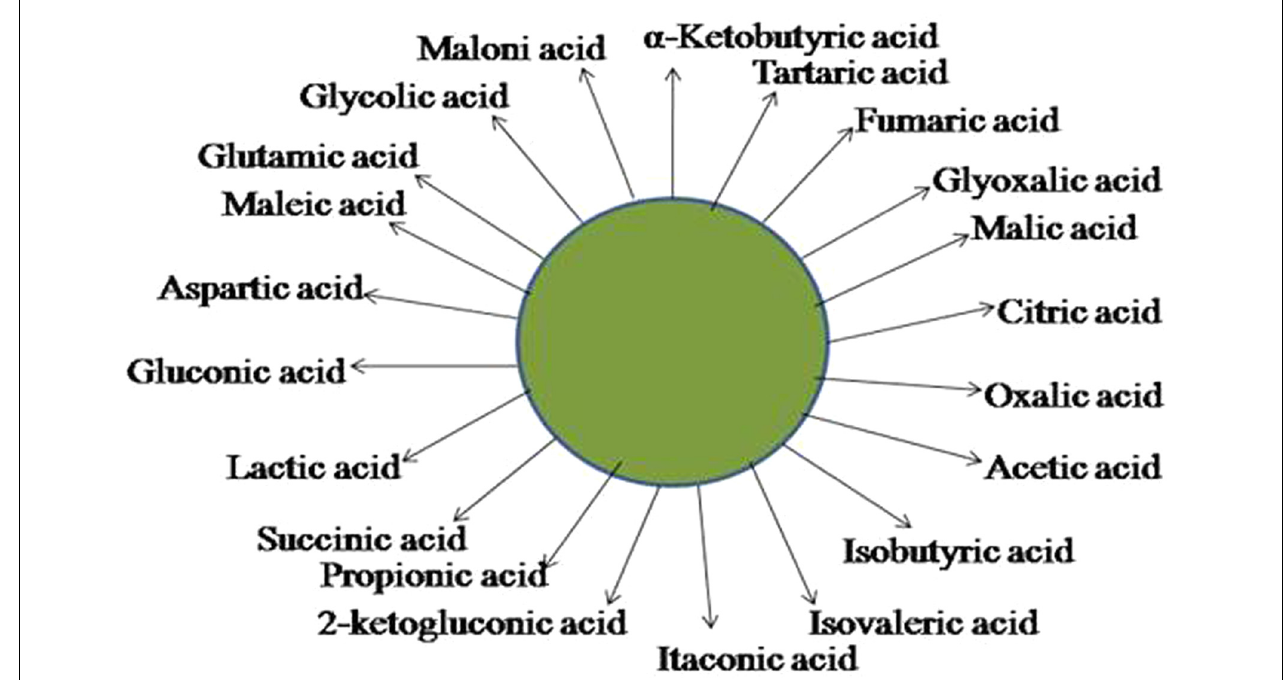
FIGURE 2 | Schematic representation of the organic acids that may be produced by PSM and used to solubilize inorganic forms of phosphate.